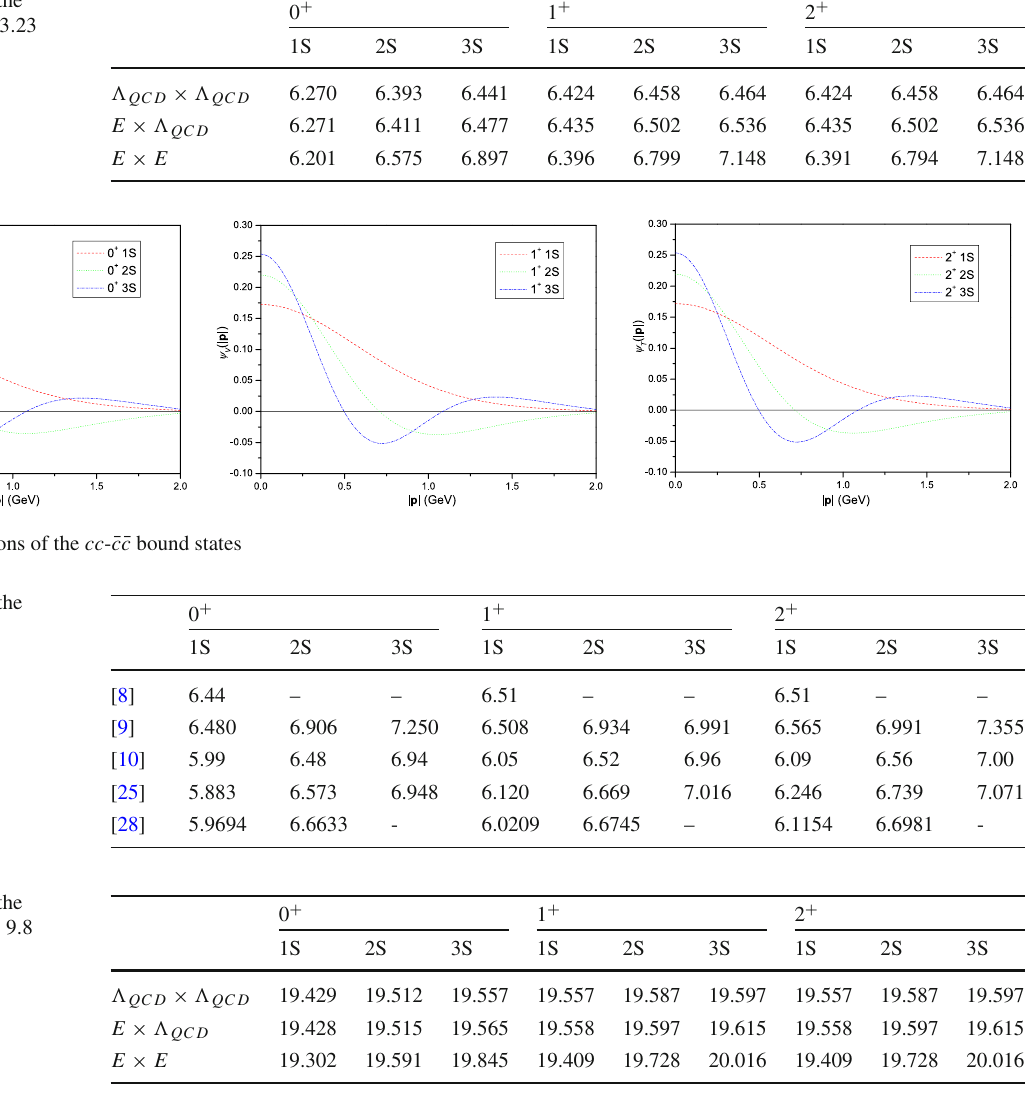
Table 2 The spectra of the cc - ¯ c ¯ c states with m cc = 3 . 23